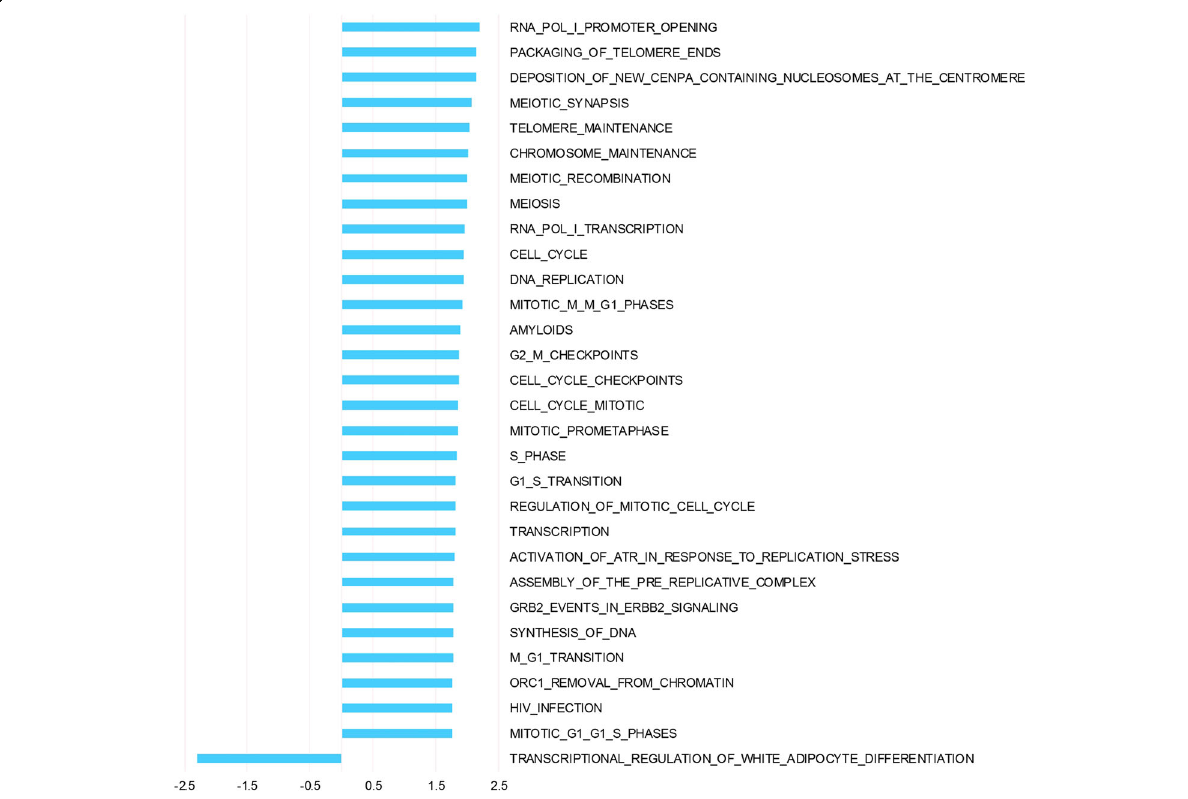
Fig. 2 Pathway analysis of interaction. Pathway analysis was performed with GSEA using ranking of genes according to the interaction term from GEE. The Normalized Enrichment Scores (NES) is depicted for all Reactome pathways significantly altered in tumor tissue as a result of surgical manipulation compared to surgical manipulation of normal